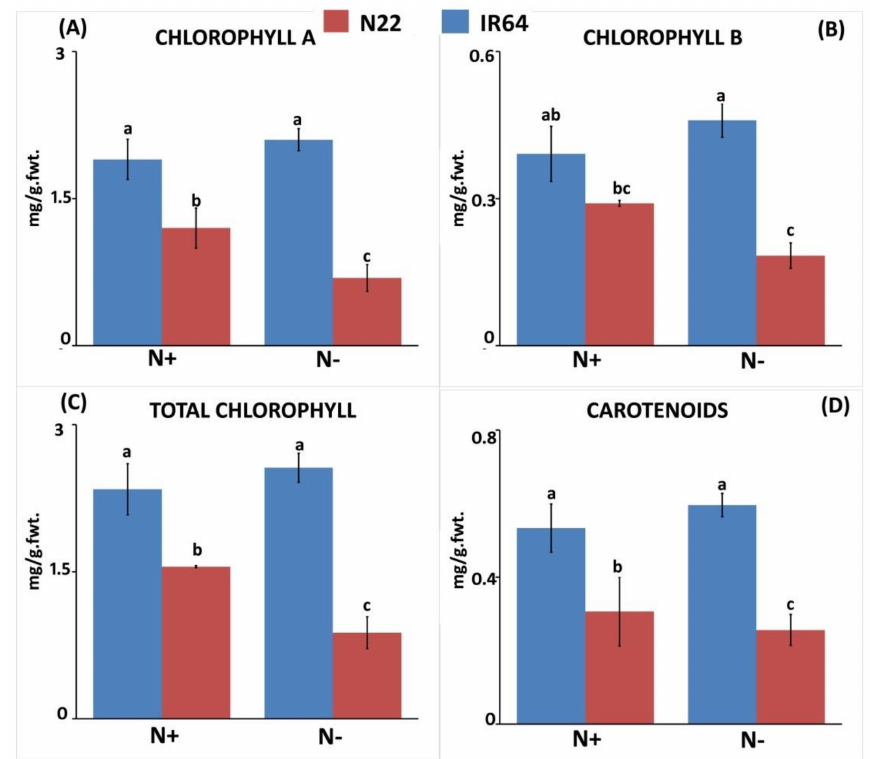
Figure 2. Chlorophyll and carotenoid pigments in IR 64 and Nagina 22 under optimal (N+) and low N (N − ). ( A ) Chlorophyll a content; ( B ) Chlorophyll b content; ( C ) Total chlorophyll; ( D ) Carotenoid content.